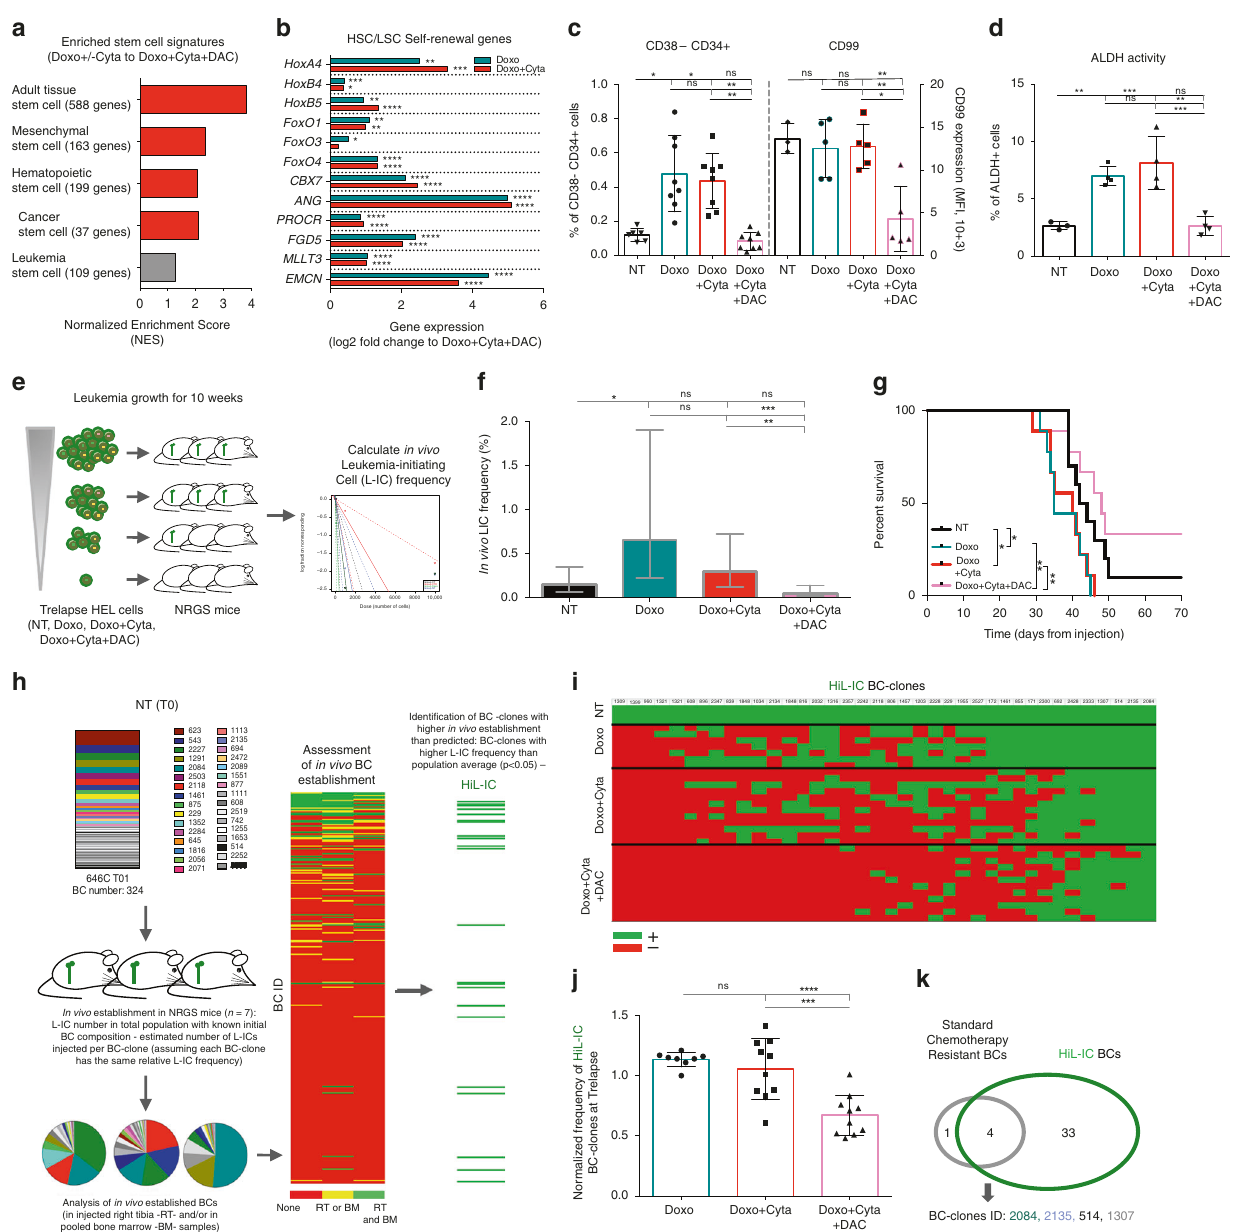
Fig. 5 Decitabine combination reduces stemness properties of relapsing hAML cells. (Data relative to HEL cell line) a GSEA of different stem-cell signatures signi fi cantly enriched (red, FDRq < 0.05 calculated by Kolmogorov-Smirnov statistical test) in Doxo ± Cyta Trelapses relative to Doxo + Cyta + DAC group (indicated NES are relative to the highest enrichment observed in Doxo ± Cyta). b Differential expression of indicated genes implicated in hematopoietic and leukemic stem cells (HSCs, LSCs) self-renewal between indicated groups at Trelapse. c Frequency of CD38-CD34 + cells (left axis, NT: n = 6, Doxo ± Cyta and Doxo + Cyta + DAC: n = 8) and CD99 mean fl orescence intensity (MFI) (right axis, NT: n = 3, Doxo ± Cyta and Doxo + Cyta + DAC: n = 5) on indicated groups at Trelapse. d Fraction (%) of cells with active ALDH enzymatic activity in indicated grups (NT: n = 3, Doxo ± Cyta and Doxo + Cyta + DAC: n = 4). e Schematic diagram of limiting-dilution assay performed with Trelapse populations from NT, Doxo ± Cyta and Doxo + Cyta + DAC cells on NRGS mice, via intra-bone marrow injection of 10000, 1000, 100 and 10 cells. f Estimated leukemia-initiating cell (LIC) frequency in Trelapse populations from indicated groups (the y-axis denotes the con fi dence intervals — lower, estimate and upper for L-IC frequency). g Survival curves of mice transplanted with 1000 cells from Trelapse NT ( n = 10), Doxo ± Cyta ( n = 9) and Doxo + Cyta + DAC ( n = 9) samples. h Schematic diagram of the strategy used to identify BC-clones with a higher L-IC frequency than the population average (HiL-IC). i Heat-map scoring the presence (green) or absence (red) of HiLIC BC-clones (columns, total of 37) present in Trelapse populations from replicates of indicated groups (lines). j Normalized frequency of HiL-IC BC-clones present at Trelapse in indicated groups (Doxo: n = 8, Doxo + Cyta ± DAC: n = 10). k Venn diagram depicting the overlap across BC-clones with HiL-IC and chemoresistant properties. Graphs of mean ± s.d., P values were determined by one-way ANOVA test. Survival curve analysis was performed by Log-rank (Mantle-Cox) testing. ns — not signi fi cant, * P < 0.05; ** P < 0.01; *** P < 0.001; **** P < 0.0001. Gene expression graph ( b ) represents mean log2(fold) change and indicated adjusted P value calculated by Wald testing. Source data are provided as a Source Data fi